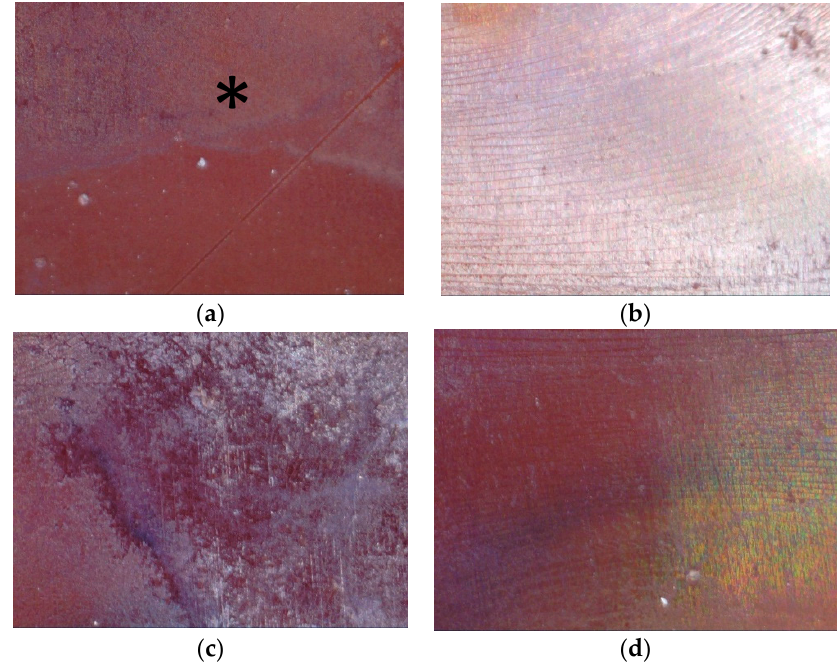
Figure A3. Optical microphotograph (2 × 1.5 mm) of EPDM rubber after 10 15 ions/cm 2 PIII, ( a ) the edge of the mask (* marks the treated area). ( b – d ) are in a center of the treated area.